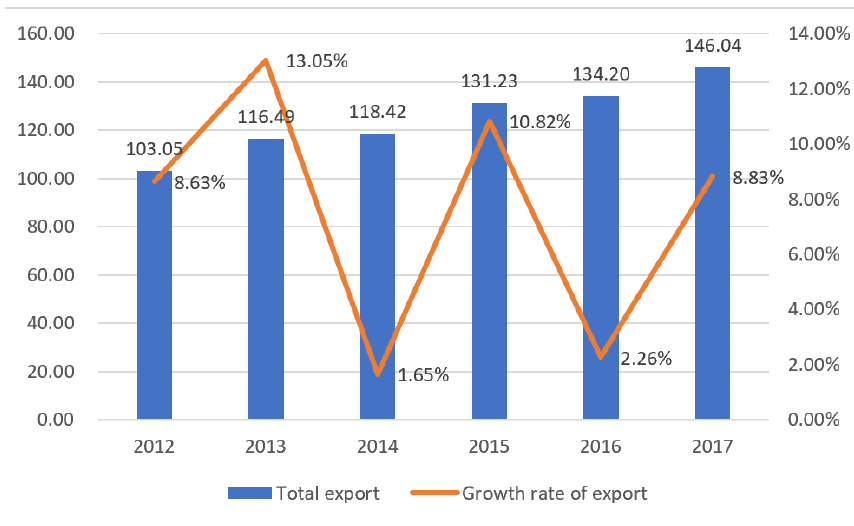
Figure 3. China’s total exports of pharmaceutical products (billion yuan). Data resource: China National Bureau of Statistics, http://www.stats.gov.cn.